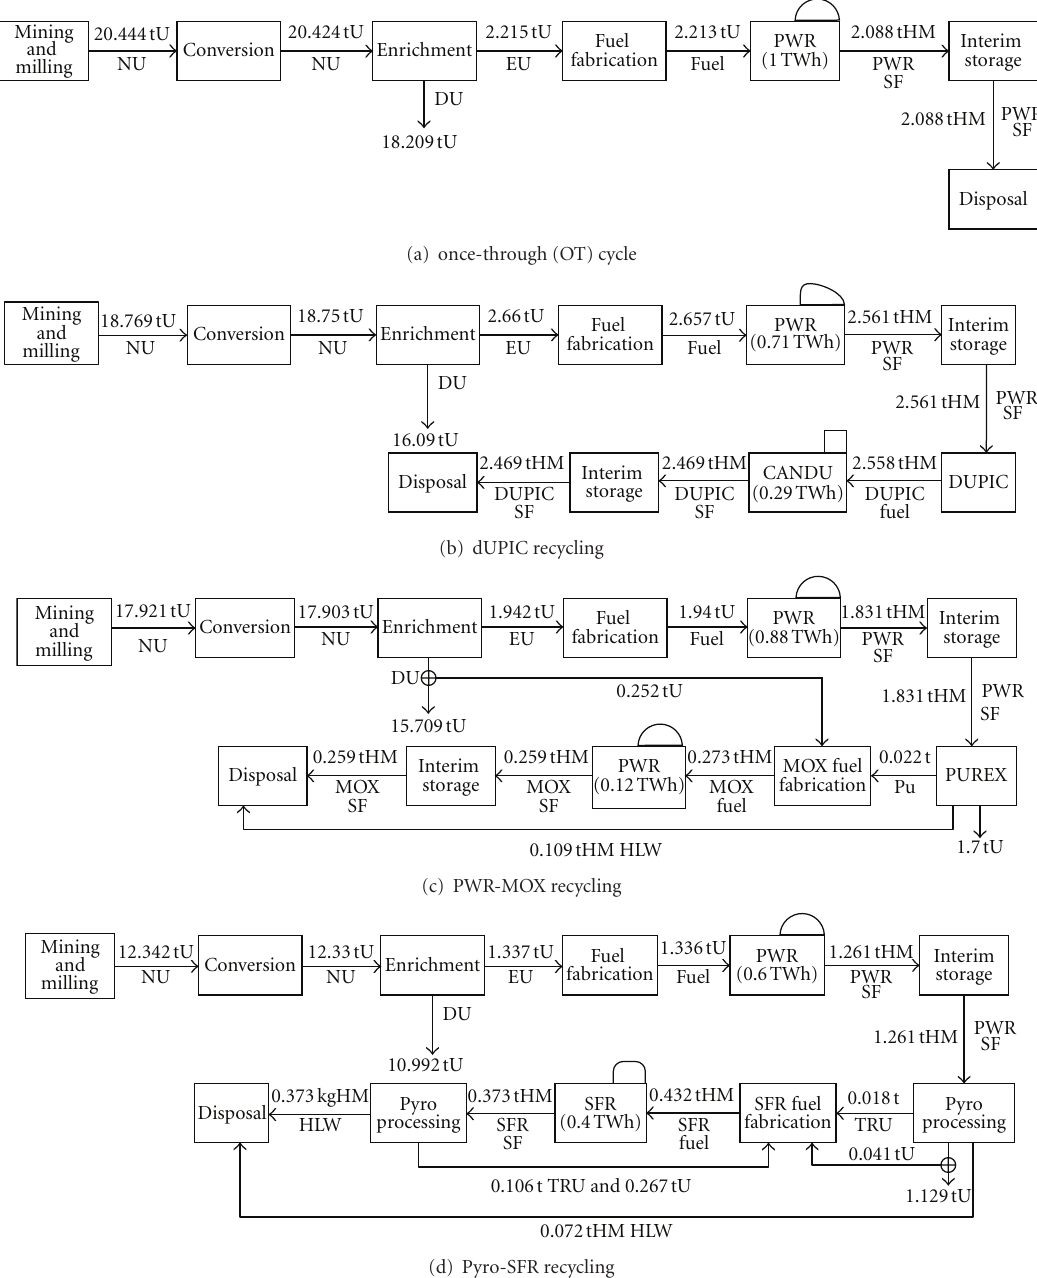
Figure 1: Main components in the nuclear fuel